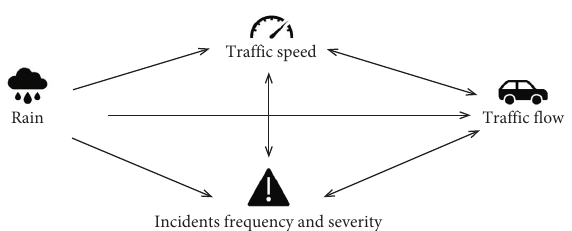
Figure 1: Relationship between rain, incidents, traffic speed, and traffic